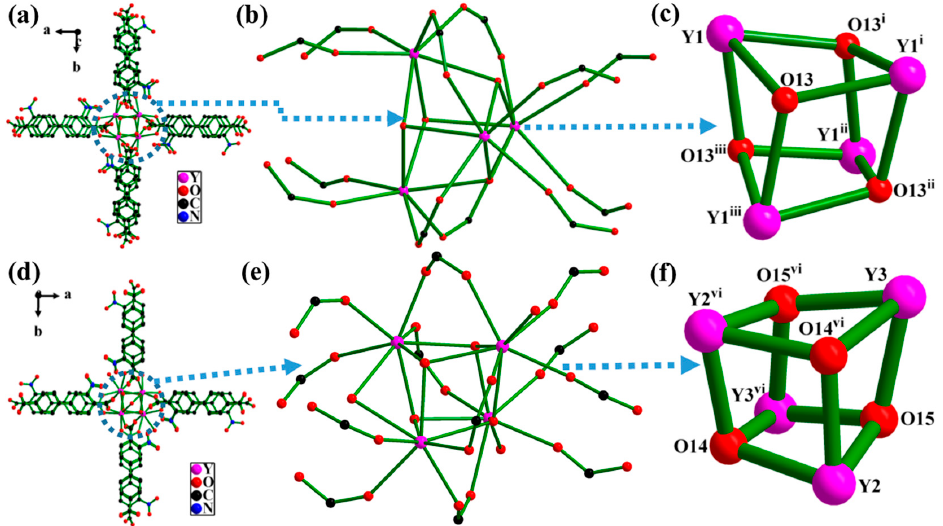
Figure 4. ( a ) and ( b ) The Y1-containing {Y 4 O 4 } cluster linked by 12 nba 2 − ligands; ( c ) The Y1- containing {Y 4 O 4 } cluster; ( d ) and ( e ) The Y2/Y3-containing {Y 4 O 4 } cluster linked by 12 nba 2 − ligands; ( f ) The Y2/Y3-containing {Y 4 O 4 } cluster.